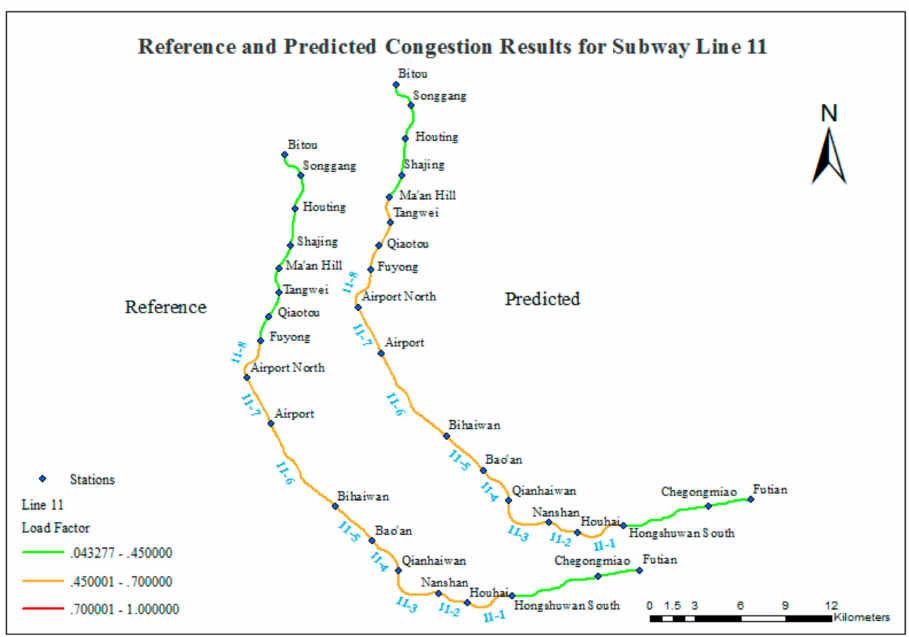
Figure 13. Comparison of reference and predicted congestion results for Line